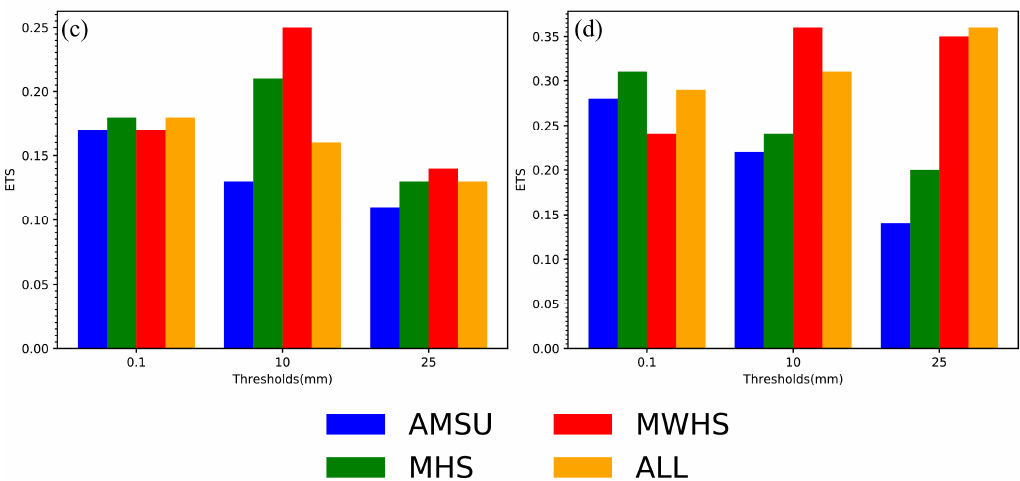
Figure 10. Accumulated 6-h rainfall ETS scores ( a ) from 0000 UTC to 0600 UTC, ( b ) from 0600 UTC to 1200 UTC, ( c ) from 1200 UTC to 1800 UTC, ( d ) from 1800 UTC to 2400 UTC.